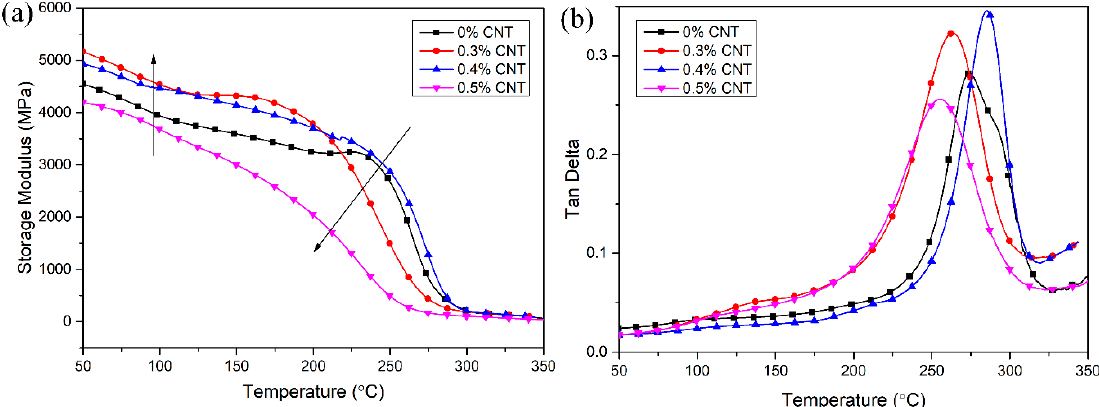
Figure 7. DMA curves of h-BN/ f -CNTs reinforced composites: ( a ) storage modulus and ( b ) tan delta.